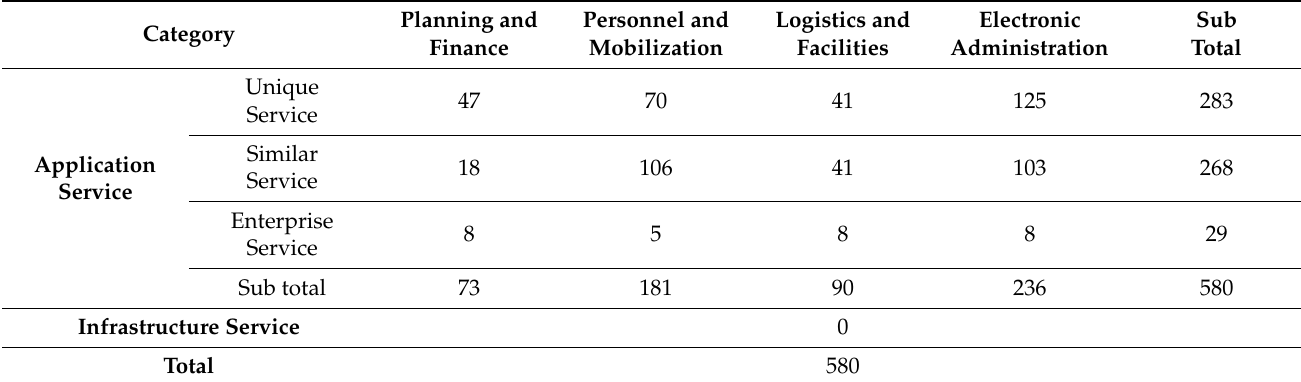
Table 2. Summary of current military SaaS portfolio.